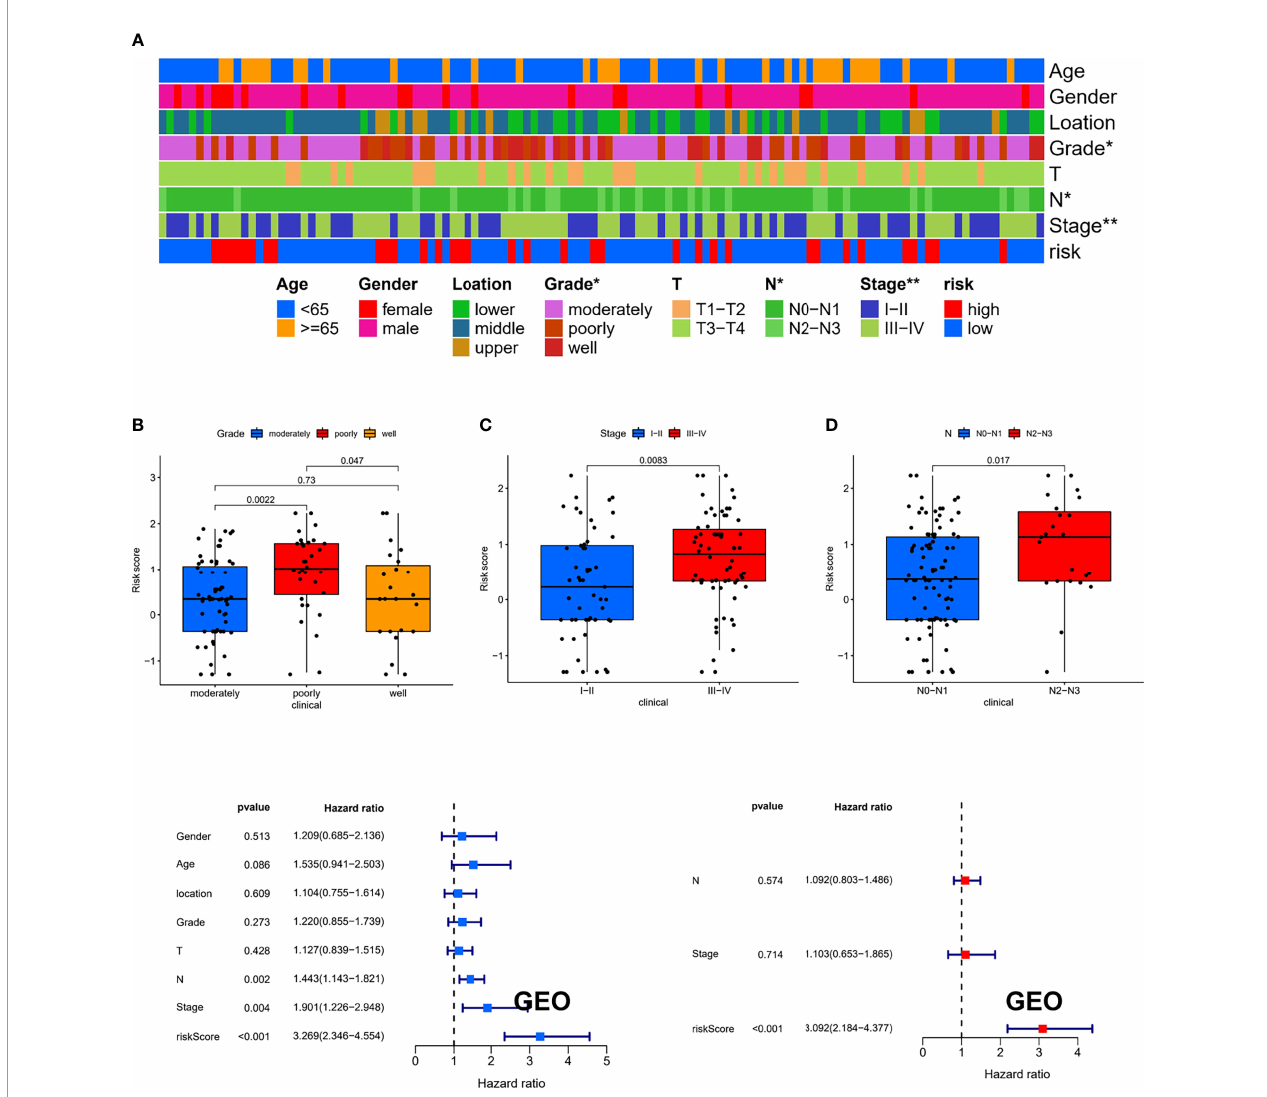
FIGURE 7 | The clinical correlation between risk-score model and clinicopathological characteristics of ESCC patients. (A) The chi-square test showed that grade, N stage, and stage were signi fi cantly related to the risk-score model. The Wilcoxon rank-sum test showed that the risk scores of ESCC patients were signi fi cantly related to status of differentiation (B) , clinical stage (C) , and status of lymph node metastasis (D) . (E, F) The results of the univariate and multivariate Cox regression analyses regarding signi fi cant survival-related clinical characteristic parameters in GEO. * P < 0.05, ** P <